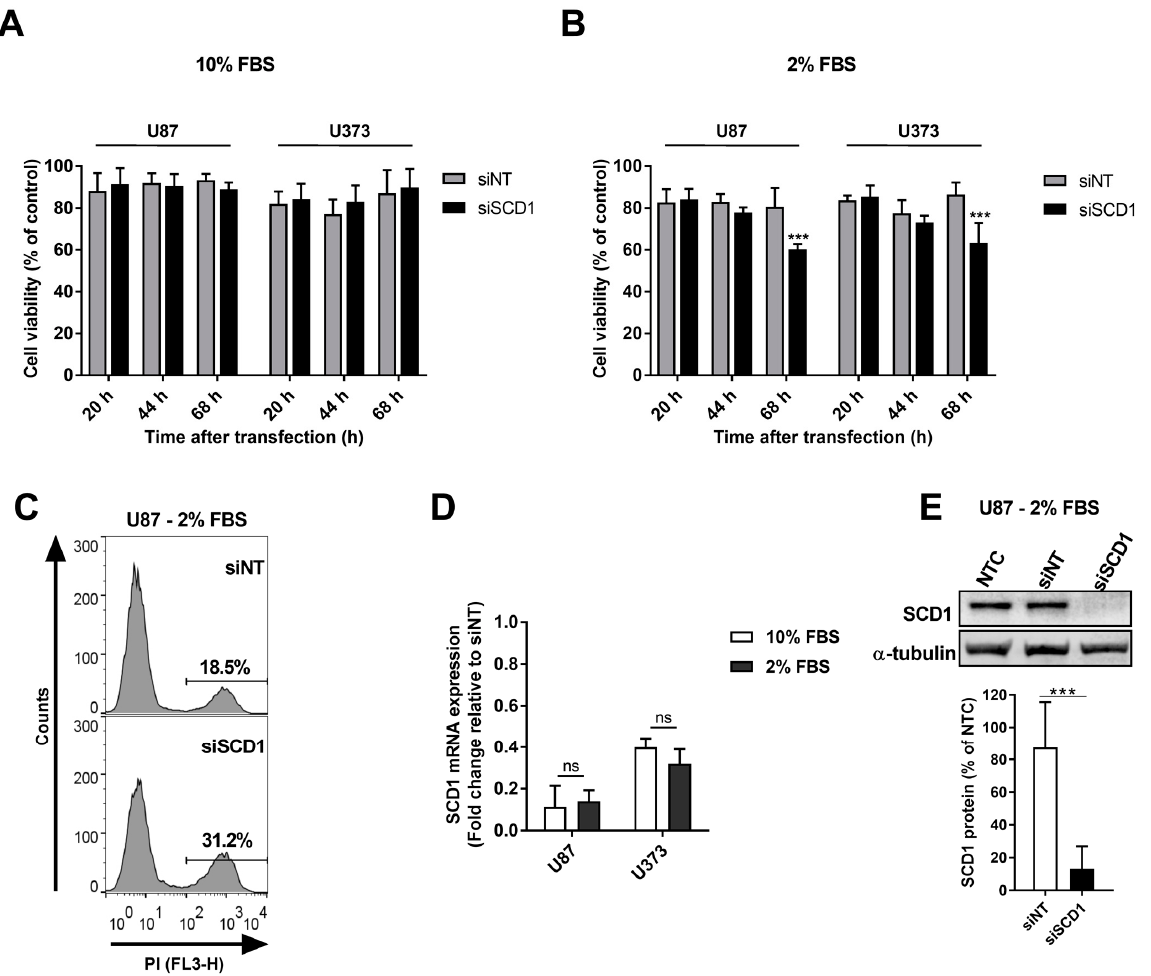
involved in cell metabolism and autophagy. Cells were plated in growth medium containing serum at a standard (10% FBS) or reduced concentration (2% FBS), and cell-doubling times were determined using the SRB assay ( A ); n = 2; unpaired two-sided t -test; * p < 0.05). The levels of SCD1 ( B ), pACC ( C ), ACC ( D ), pACC/ACC ( E ), AMPK ( F ), PI3K ( G ), pAKT ( H ), AKT ( I ), pAKT/AKT ( J ), HK-II ( K ) and LC3B II/I ( L ) were evaluated by Western blot analysis in normal human astrocytes (NHAs) and U87 cells at 96 h after plating. U87 cells were cultured in growth medium containing 2% or 10% FBS. Results of protein expression and protein ratio are presented with respect to NHAs ( n = 2–3; one-way ANOVA followed by Tukey’s test; * p < 0.05, ** p < 0.01, *** p < 0.001 vs. NHAs; # p < 0.05, ## p < 0.01 vs. U87 10% FBS).